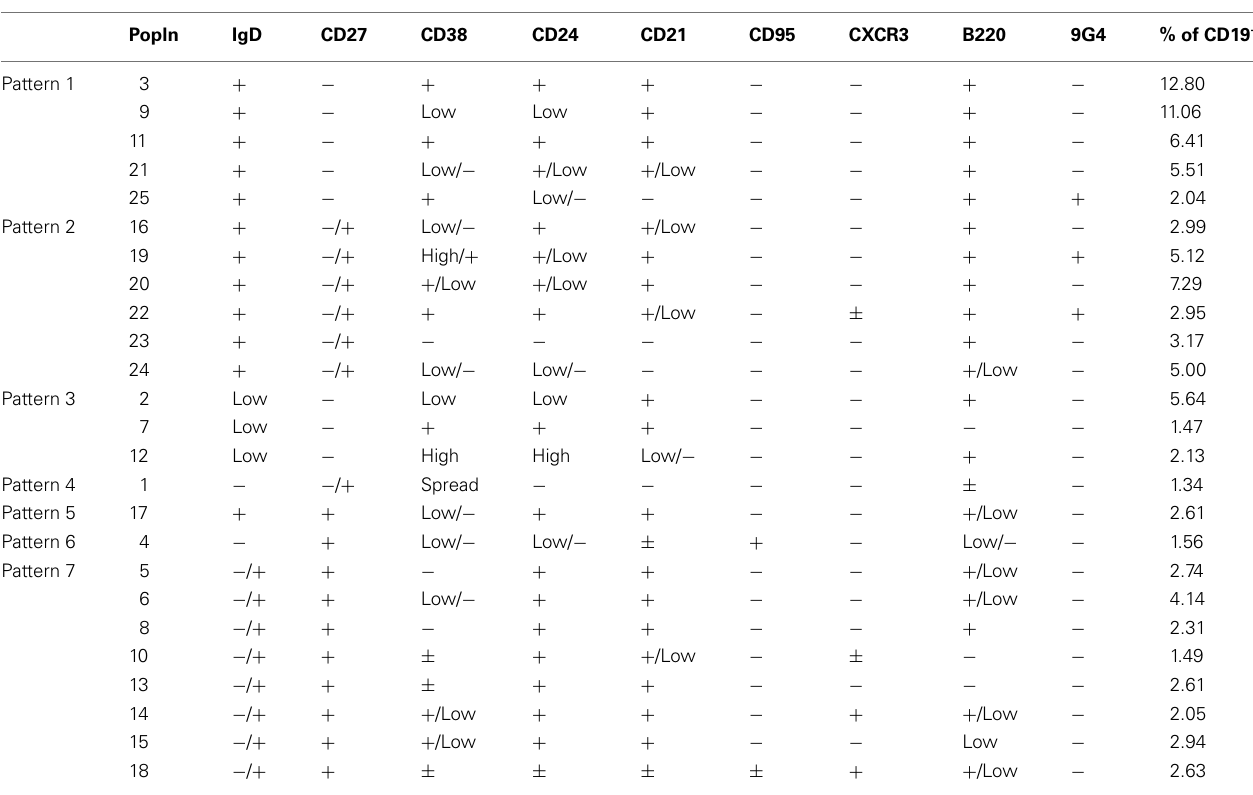
Table 3 | Characteristics of PBMC B cell clusters identified by